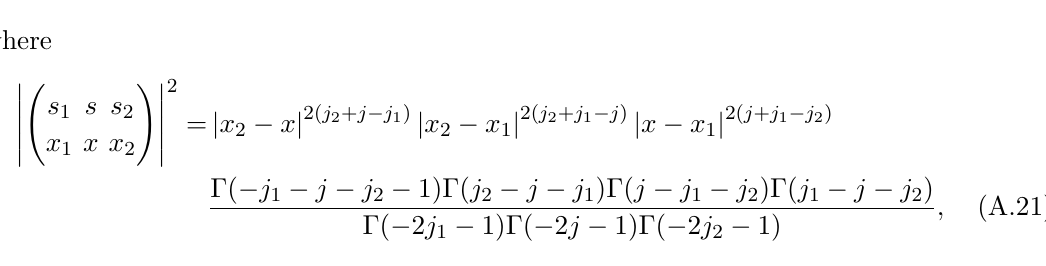
Figure 13 . Choice of oriented slices on a three-holed sphere, with holonomies U , V , W restricted by W = UV